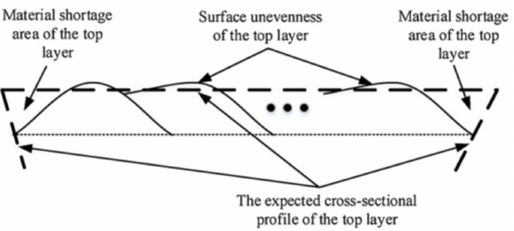
Figure 41. Fabrication issues on the top layer. Reprinted with permission from Ref. [82]. Copyright 2018